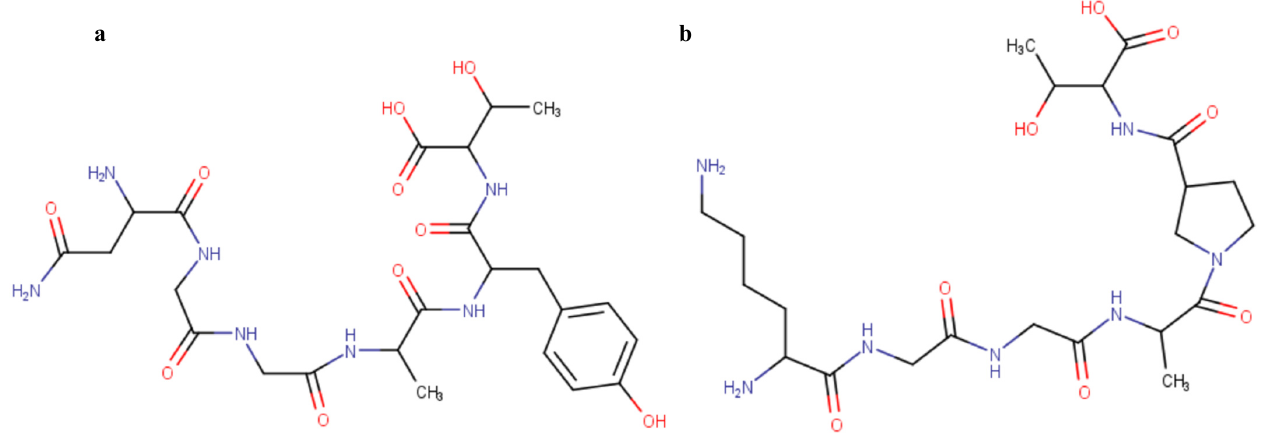
Figure 8. Two-dimensional structures of the non-structural protein cleavage points ( a ) CS1 and ( b ) CS2 used in the study.